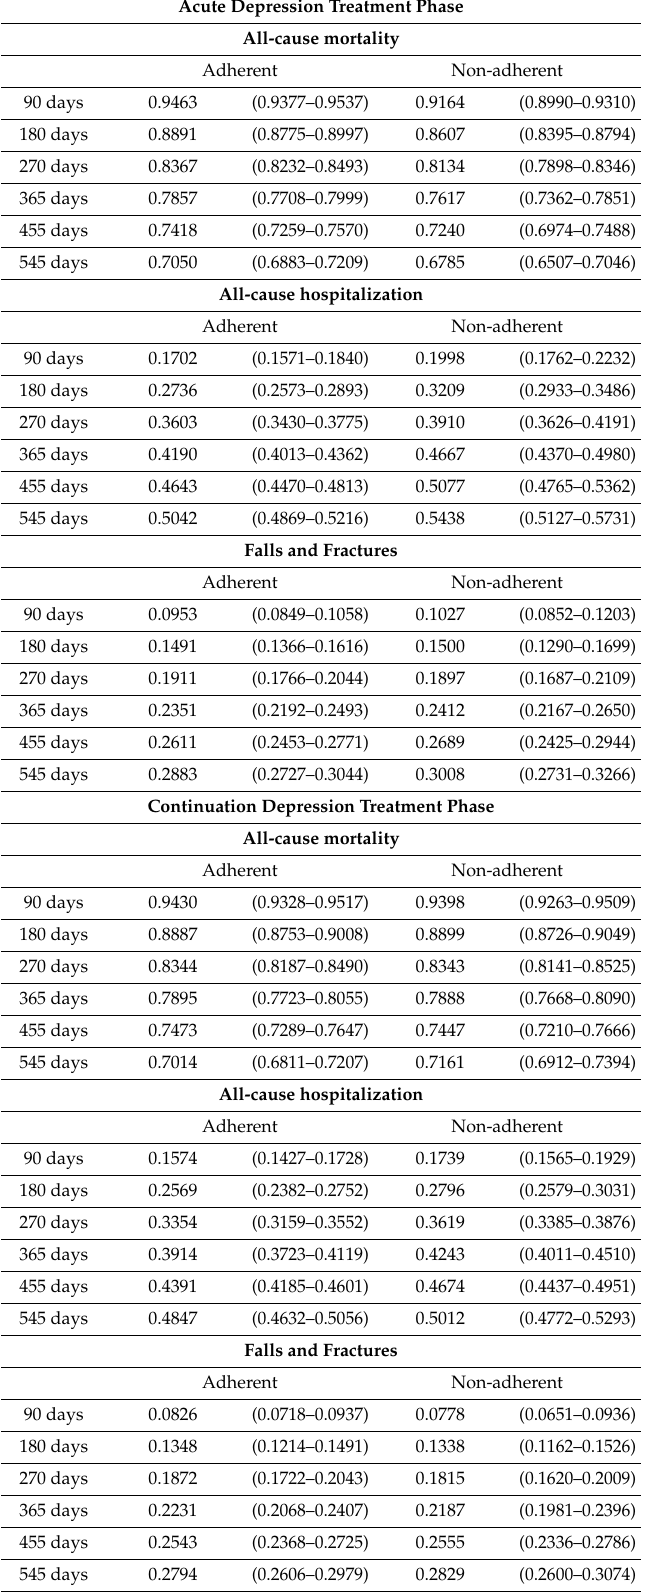
Table 3. Survival estimates (95% CI) for all-cause mortality and cumulative incidence estimates (95% CI) at 90, 180, 270, 365, 455, and 545 days for hospitalization and falls and